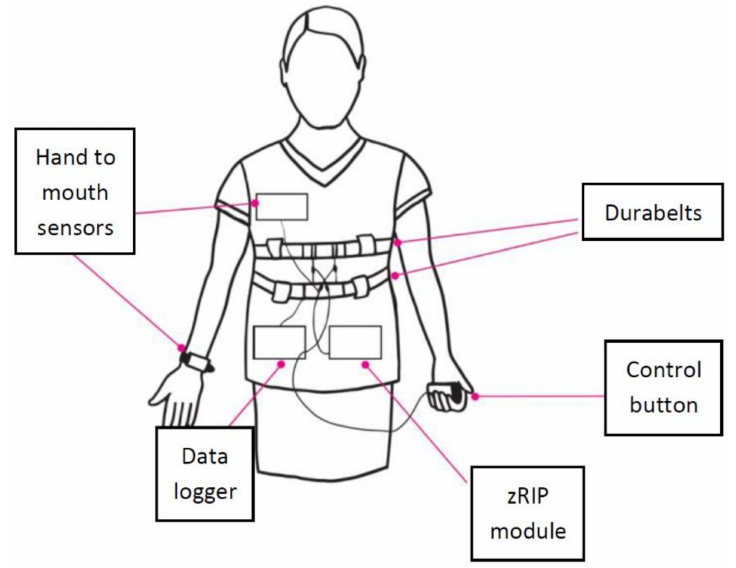
Figure 1. Sensors of the system presented in Reference